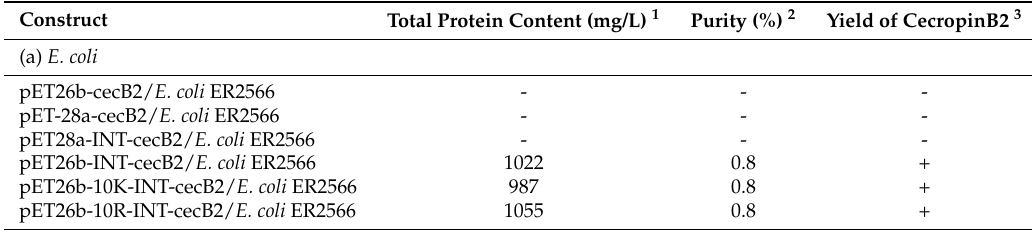
Table 1. Yield of cecropinB2 under various expression systems.